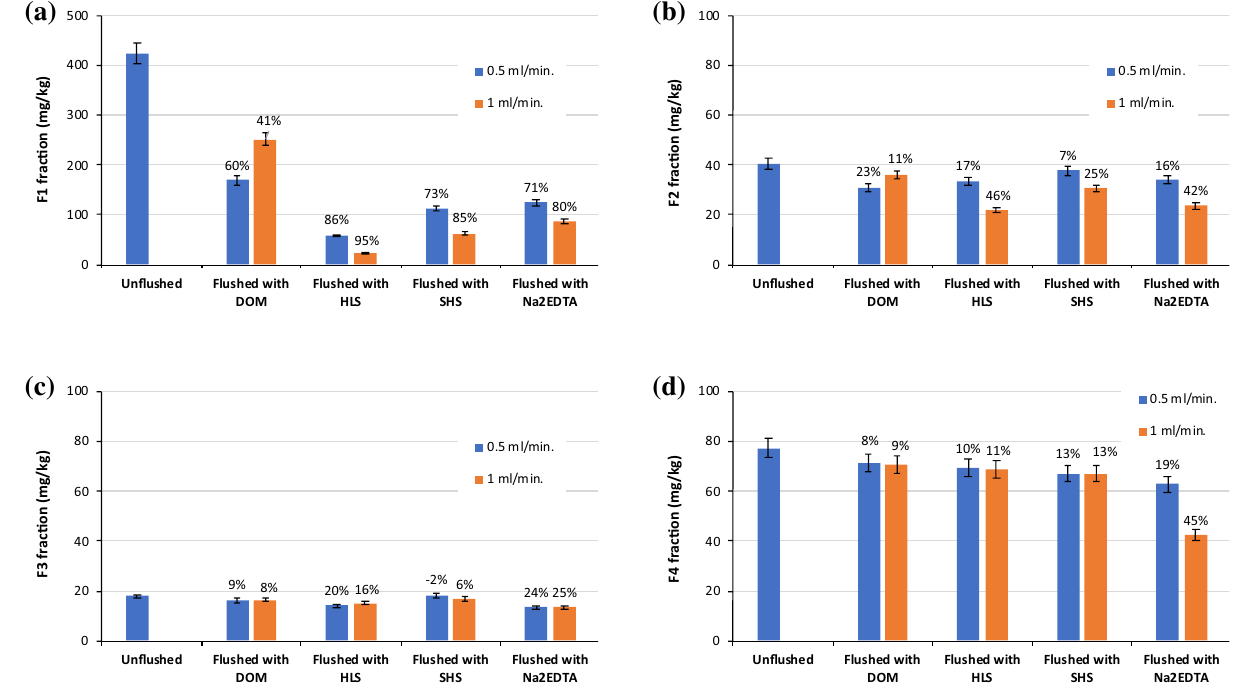
Figure 10. Changes in Zn distribution in unflushed soil and soil flushed with DOM, HLS, SHS and Na 2 EDTA at two flow rates. The values above the bars mean the removal efficiency of Zn from individual fractions: ( a ) F1 fraction, ( b ) F2 fraction, ( c ) F3 fraction, ( d) F4 fraction. Data are expressed as mean values (n = 2) ± standard deviation error